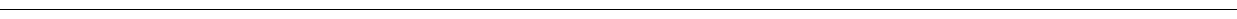
Fig. 3 CSDE1 prevents neural differentiation of hESCs. a Bright fi eld images of H9 hESCs. Knockdown of CSDE1 results in the proliferation of fl attened and elongated cells that grew in monolayer colonies with reduced cell contact. Furthermore, loss of CSDE1 induces a spontaneous differentiation into neuronal cells. Scale bar represents 250 μ m. b Percentage of alkaline phosphatase (AP)-positive colonies after fi ve days of culturing without removing differentiated cells. Graph represents the mean ± s.e.m. of the percentage observed in four independent experiments (we assessed approximately 150 total colonies in each independent experiment). c qPCR analysis of hESCs cultured for fi ve days without removal of differentiated cells. Graph (relative expression to non-targeting (NT) shRNA) represents the mean ± s.e.m. of four independent experiments with three biological replicates. d Western blot analysis with antibodies to CSDE1, OCT4 and SOX2. β -actin is the loading control. hESCs were grown for fi ve days without removing differentiated cells. e Immunocytochemistry of H9 hESCs grown for fi ve days without removal of differentiated cells. OCT4, PAX6, and Hoechst staining were used as markers of pluripotency, neuroectodermal differentiation, and nuclei, respectively. Scale bar represents 20 μ m. f – j Graphs represent the percentage (mean ± s.e.m.) of OCT4 and PAX6-positive cells/total nuclei after fi ve days in culture without removal of differentiated cells: f H9 hESCs, n = 3 independent experiments, 550 – 700 total cells per experiment; g H9 hESCs, n = 3, 420 – 1000 cells per experiment; h H1 hESCs, n = 3, 290 – 960 cells per experiment; i HUES9 hESCs, n = 3, 320 – 710 cells per experiment; j HUES6 hESCs, n = 3, 200 – 550 cells per experiment. KD = CSDE1 knockdown. KO = CSDE1 knockout. All the statistical comparisons were made by Student ’ s t-test for unpaired samples. P -value: *( P < 0.05), **( P < 0.01), ***( P < 0.001), **** ( P <